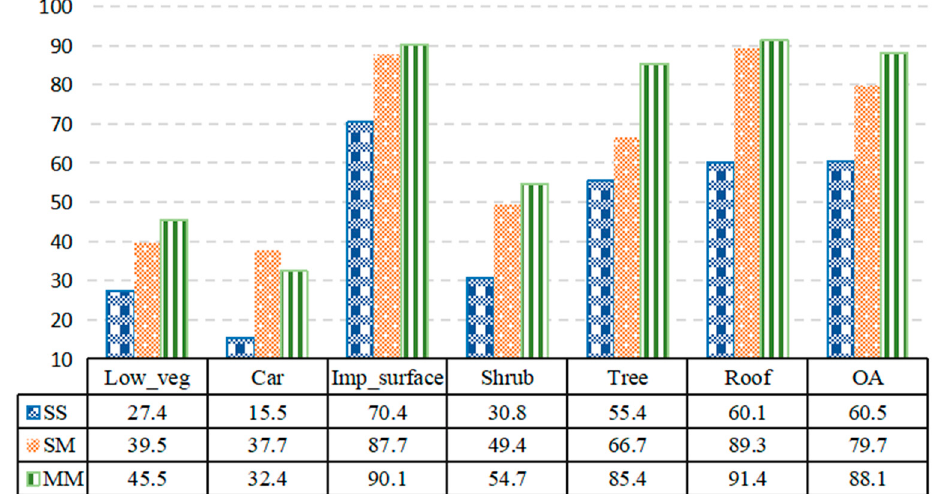
Figure 5. All kinds of ground features and overall classification accuracy.